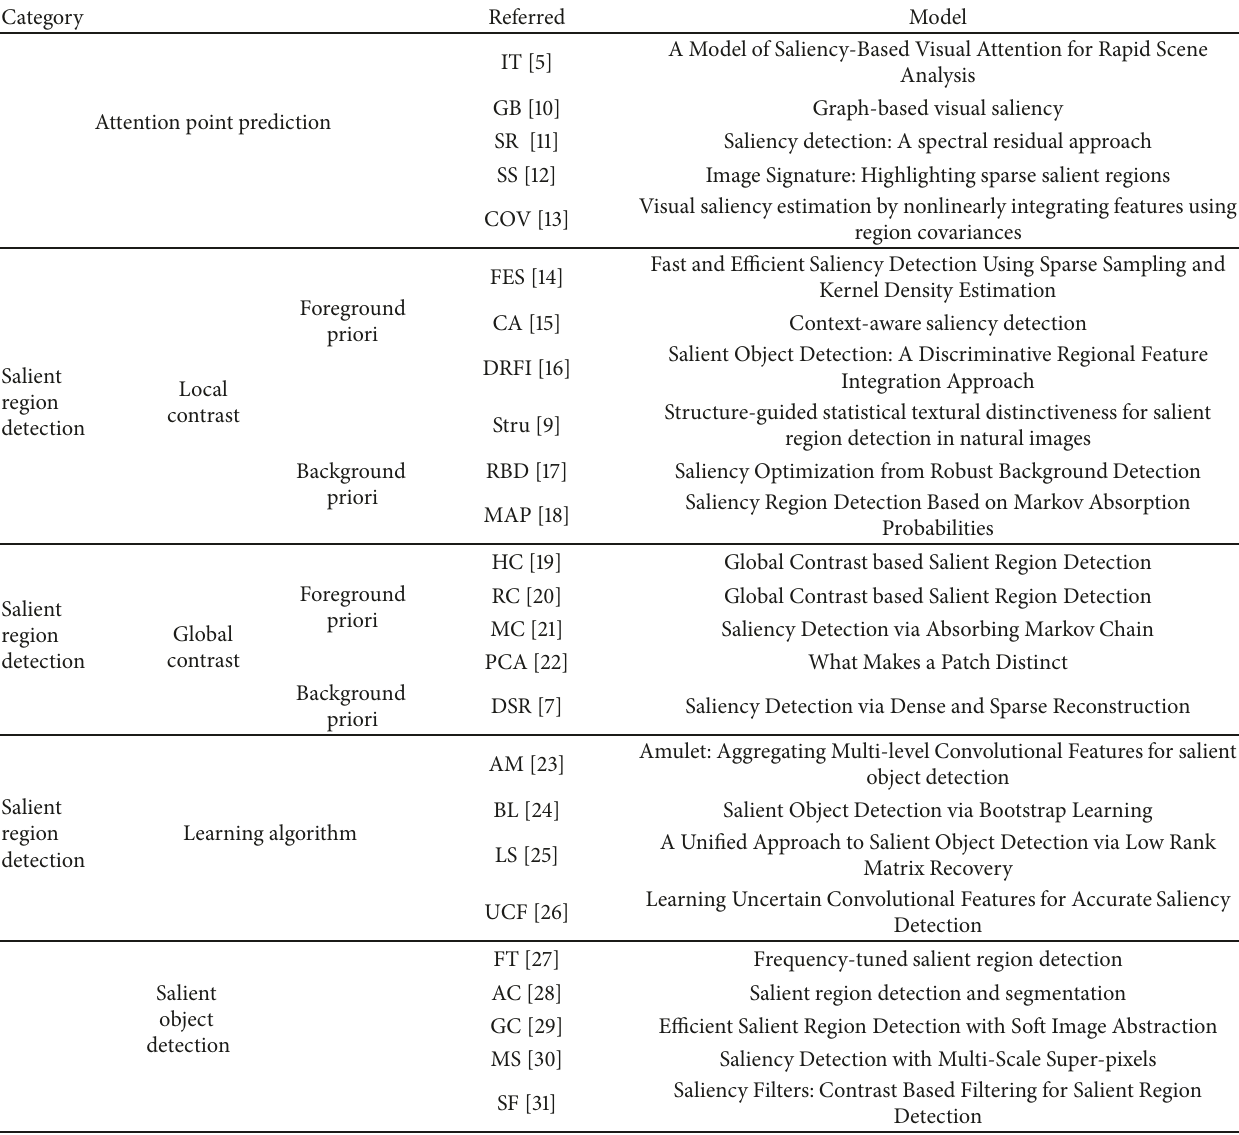
Table 1: Classification of saliency